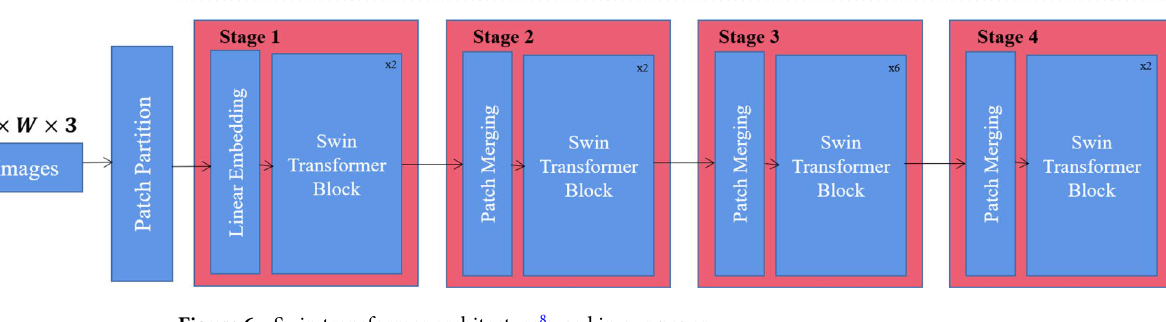
Figure 6. Swin transformer architecture 8 used in our